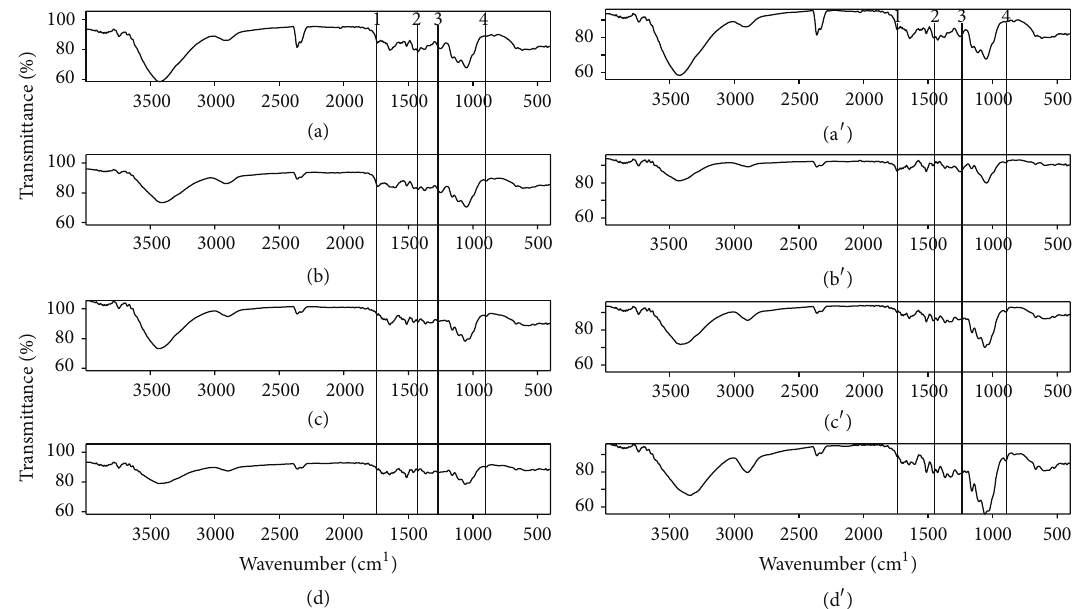
Figure 4: FTIR spectra of corn stalk and cellulose-rich materials: (a) untreated corn stalk; (b) [BMIM]Cl/DMSO; (c) [HMIM]Cl; (d) [HSO 3 - pMIM]HSO 3 ; (a 󸀠 ) untreated corn stalk; (b 󸀠 ) [BMIM]Cl/DMSO/H 2 O; (c 󸀠 ) [HMIM]Cl/H 2 O; (d 󸀠 ) [HSO 3 -pMIM]Cl/H 2 O.